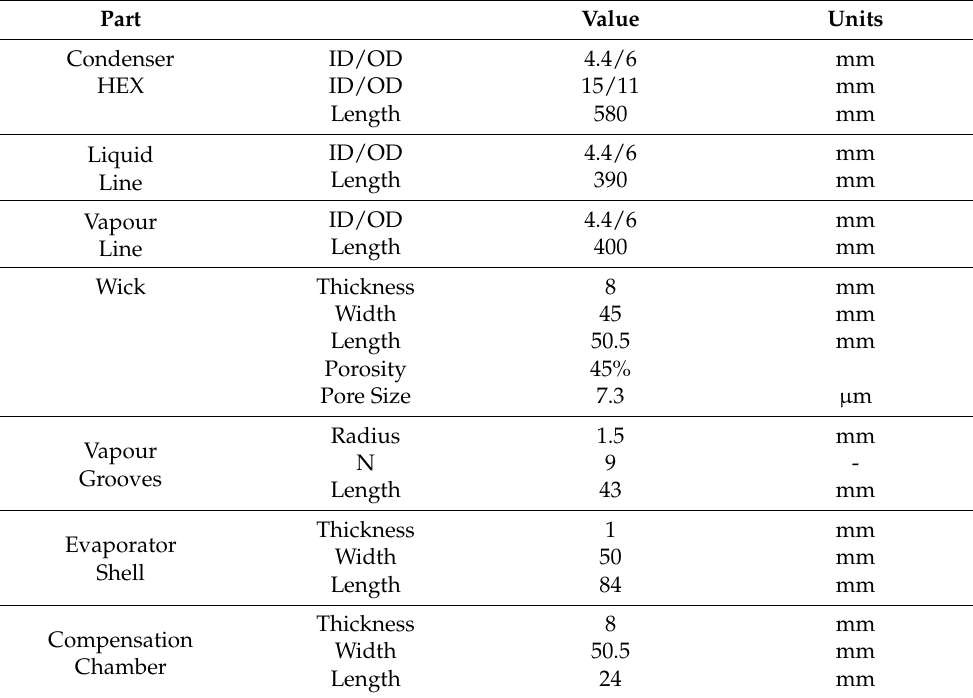
Table 3. Geometry of the LHP used in the present investigation (all parts are made in copper).